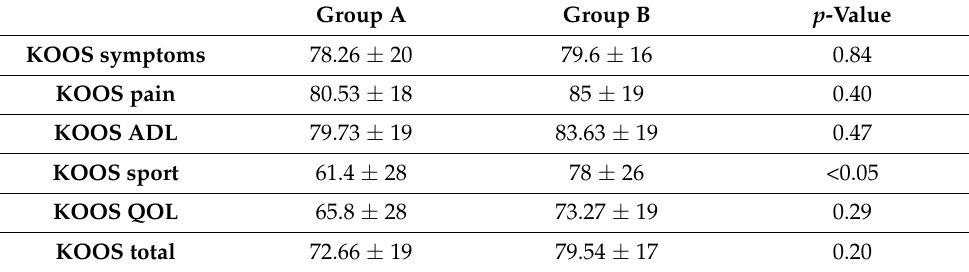
Table 2. Postoperative assessment of KOOS